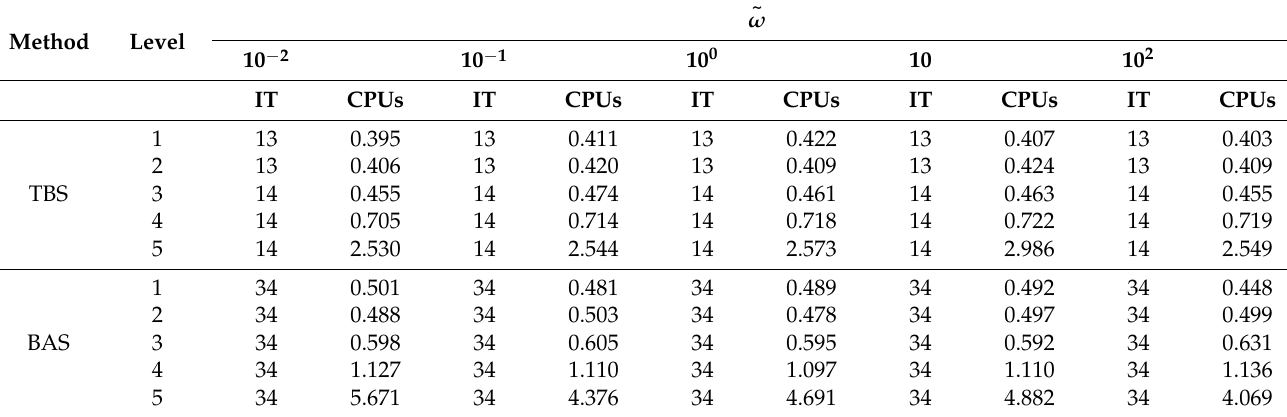
Table 2. Different mesh refinement levels and (cid:101) ω , the results of iteration method in the 2D case, with ε = 10 − 2 . Method